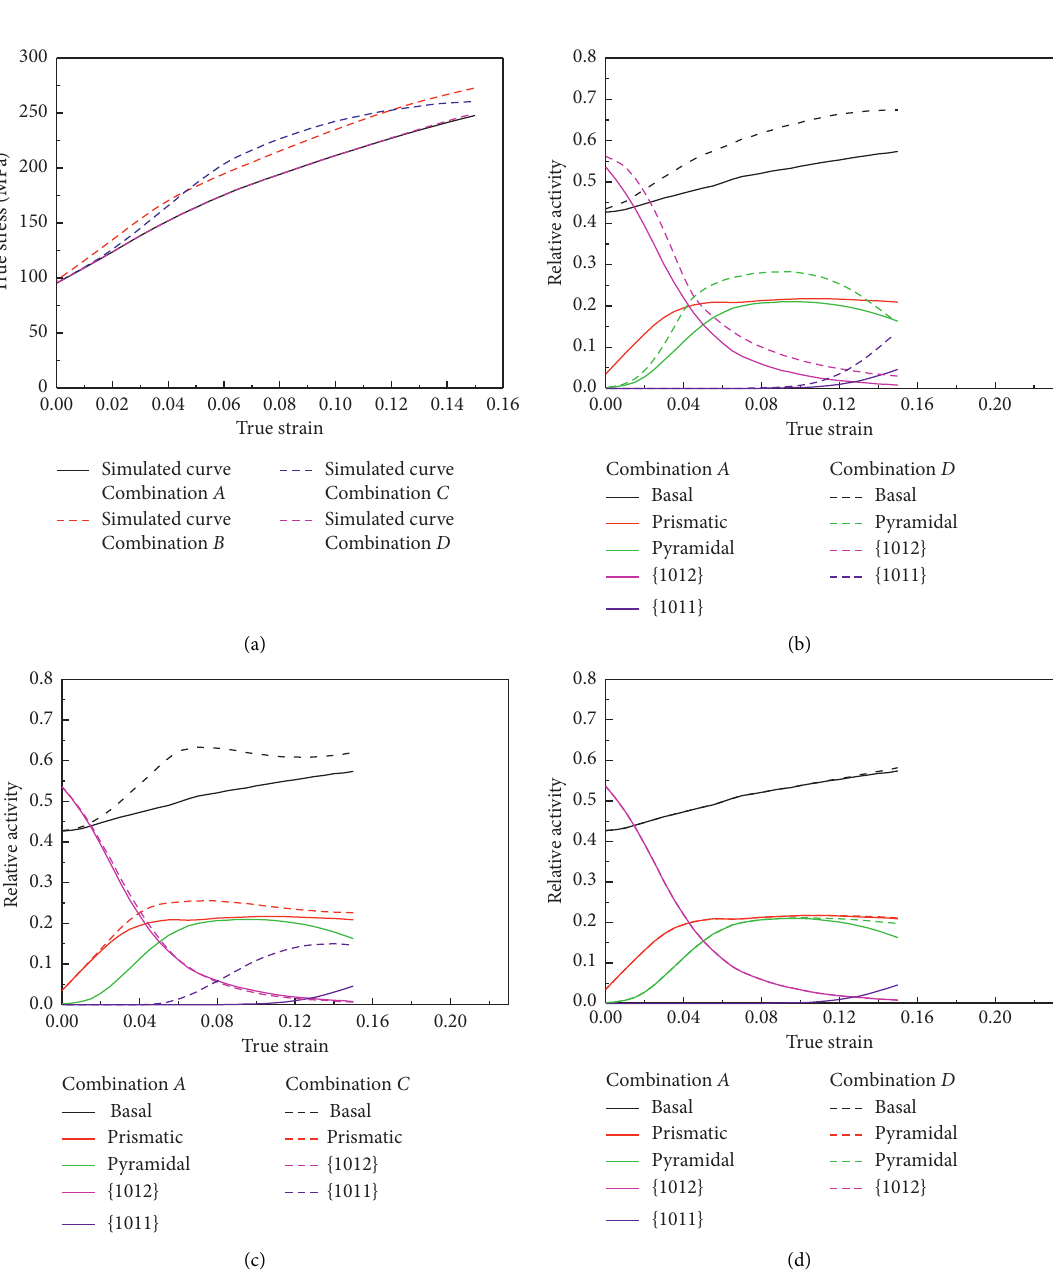
Figure 5: (a) Predicted stress–strain curves of AZ31 magnesium alloy under axial compression; (b)–(d) corresponding slip and twinning activities predicted by the VPSC model in the cases of combinations B, C, and D